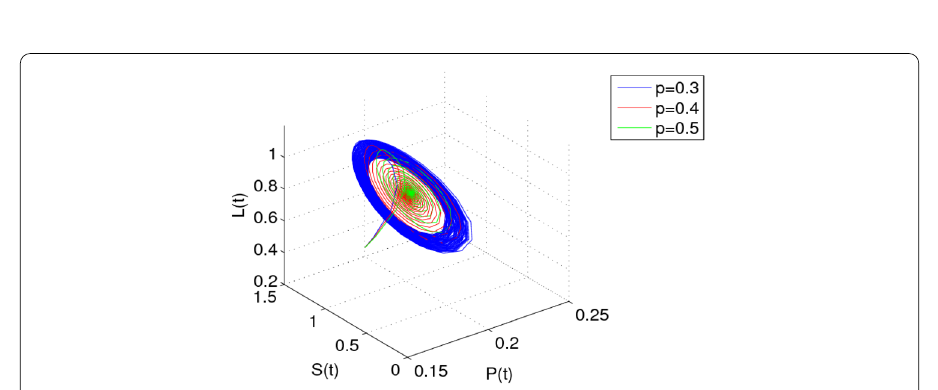
Figure 5 Time plots of P , L , S and Q for different φ at τ = 2.0505. The rest of the parameters are taken as given in the text